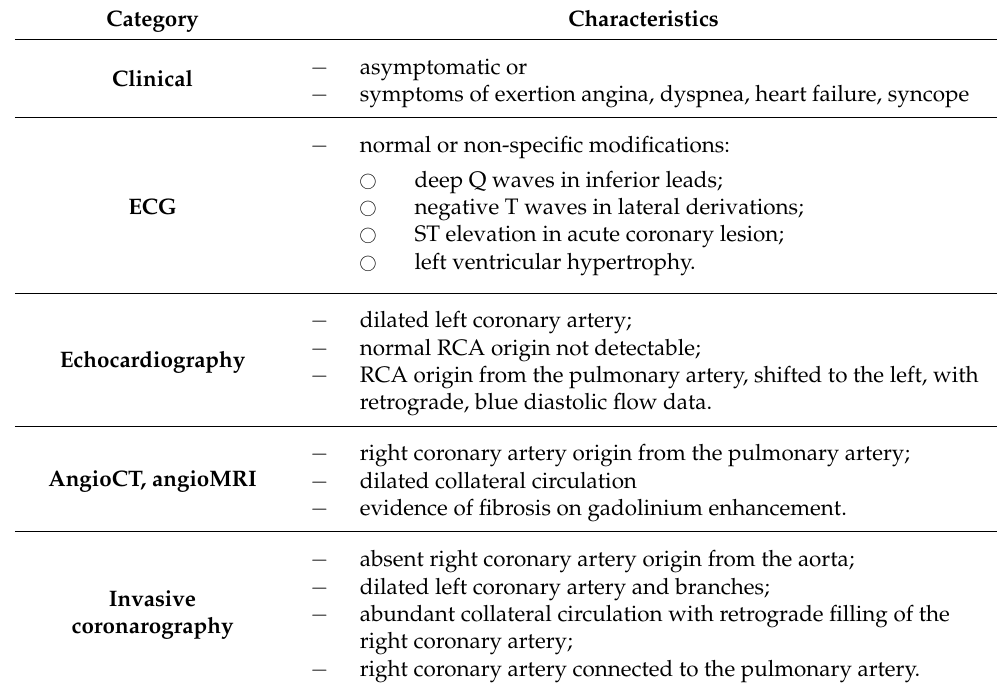
Table 1. Diagnostic tools in